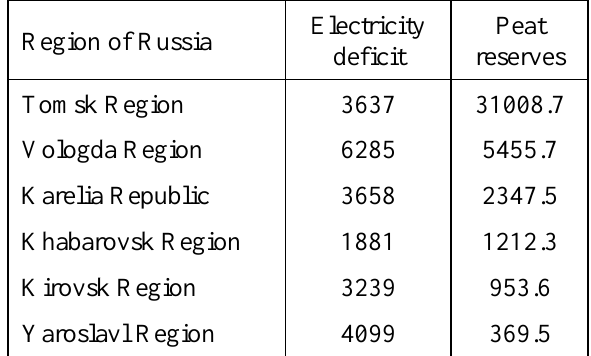
Table 6. Regional comparison of electricity